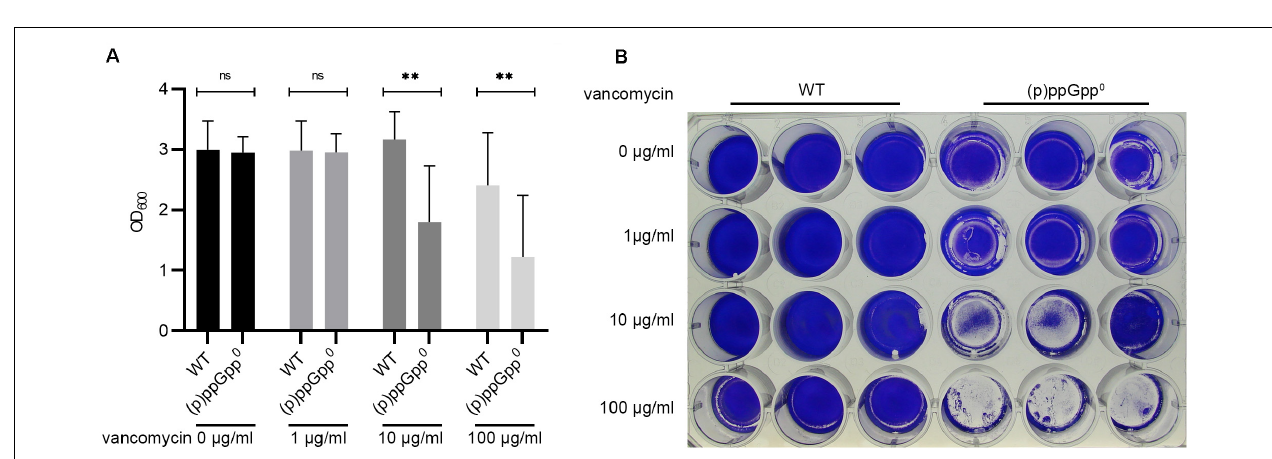
FIGURE 4 | Biofilm formation under stringent conditions is independent of CodY and Agr. Biofilm formation under non-stressed and vancomycin-stress (0.78 µ g/ml vancomycin) in CDM, 24 h. Three separate experiments were performed with biological triplicates each. Error bars represent the standard deviation, statistical significance based on ordinary one-way ANOVA (ns: P > 0.05).